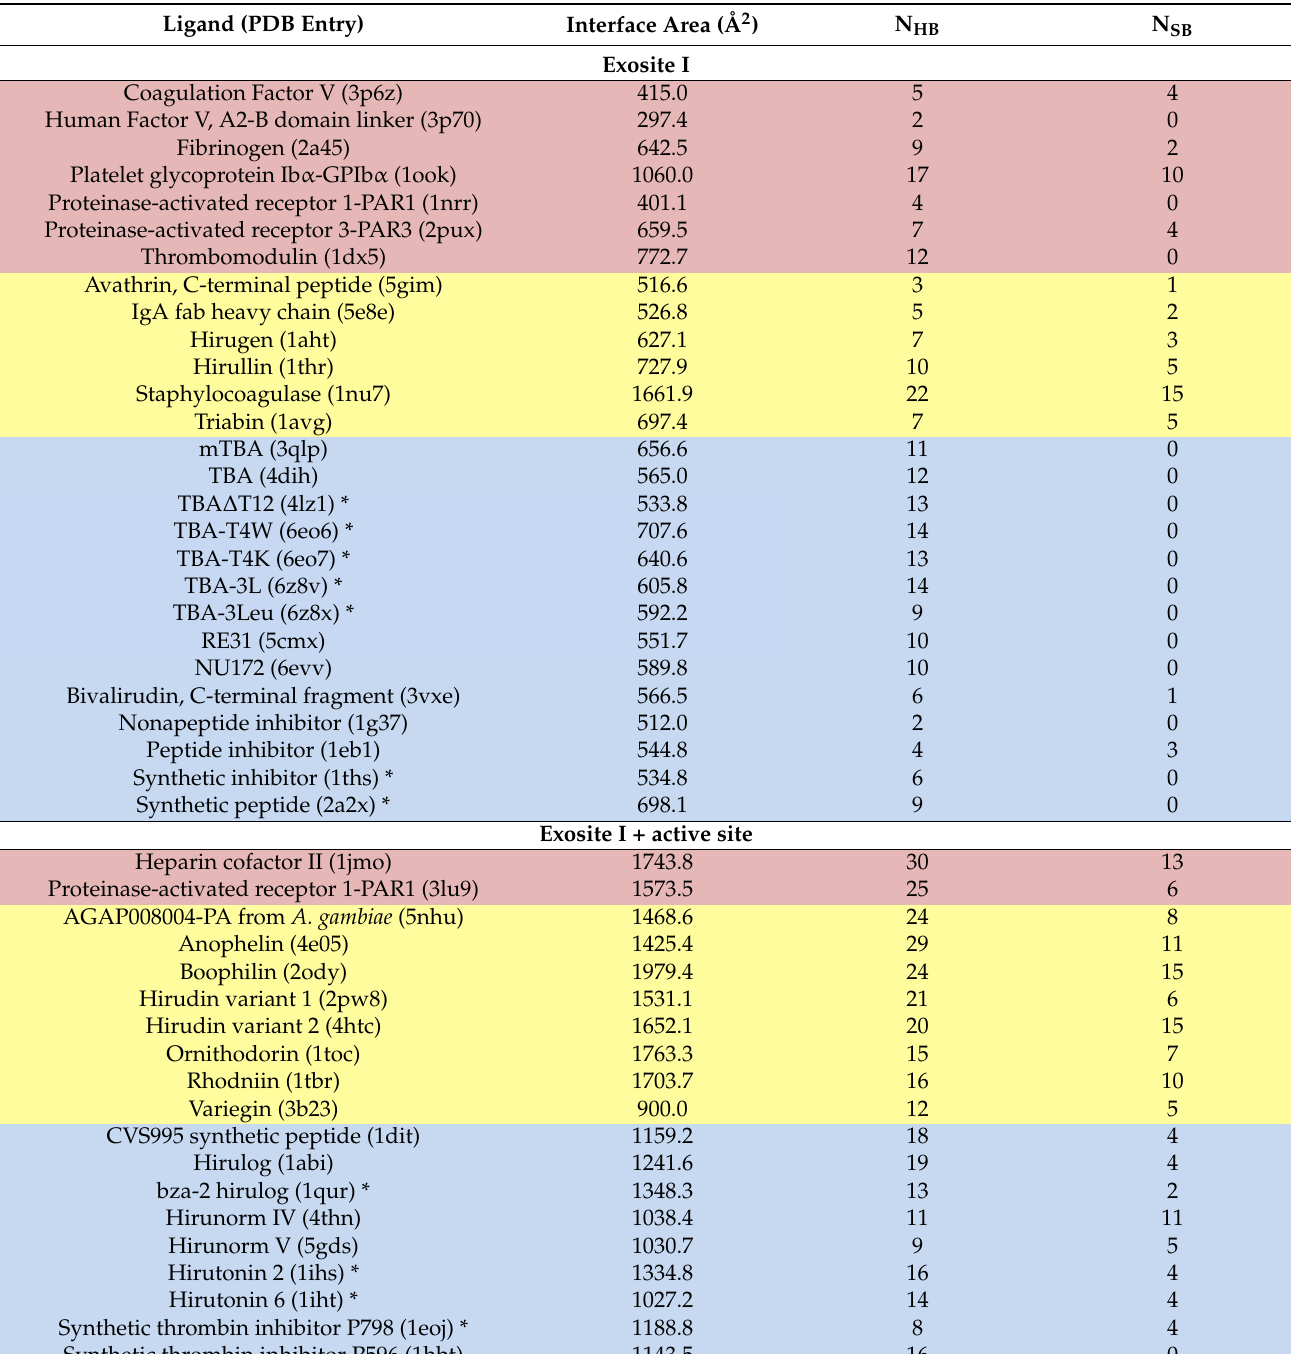
Table 4. Interaction data (interface area, number of H-bonds/salt bridges) detected in the crystallographic structures of thrombin complexes with ligands bound at exosite I or at both exosite I and active site. Functional partners, natural inhibitors, and synthetic compounds are highlighted in pink, yellow, and light blue, respectively. Analyses have been conducted using the PISA program